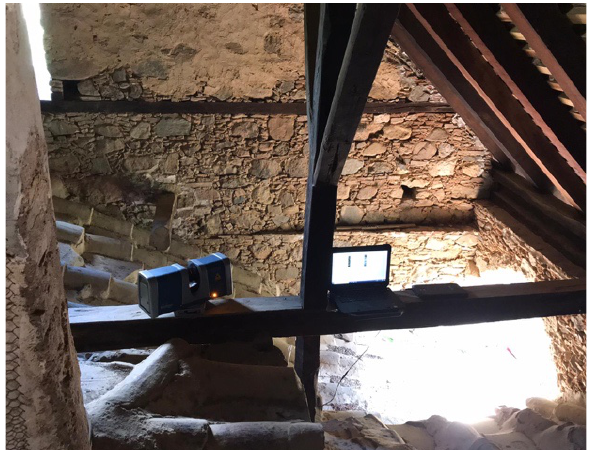
Figure 3. Agios Nikolaos tis Stegis, Kakopetria, TLS 3D survey, inner